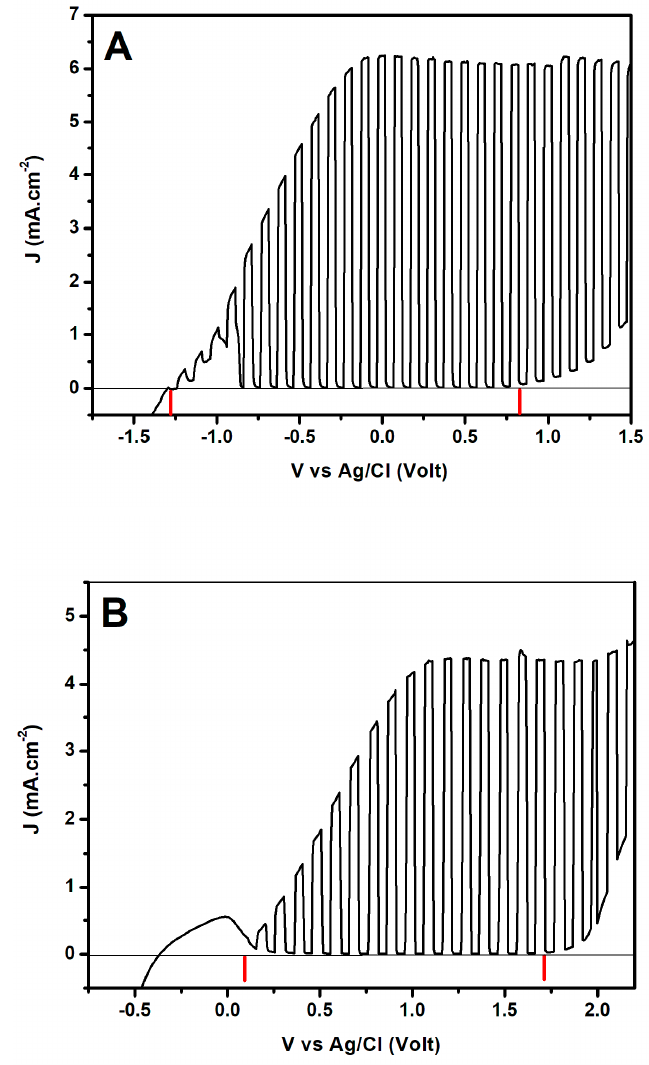
Figure 6. Photocurrent production using a CdS/TiO 2 ( A ) or a WO 3 ( B ) photoanode. The active area of both photoanodes was 1 cm 2 . The counter-electrode was a carbon cloth covered on one side by mesoporous carbon, with an active area of 15 cm 2 (3 cm × 5 cm). The electrolyte was 0.5 M NaOH in the case of CdS/TiO 2 , and 0.5 M Na 2 SO 4 in the case of WO 3 . Ethanol at 5% (v/v) was added in the electrolyte of the anode compartment.